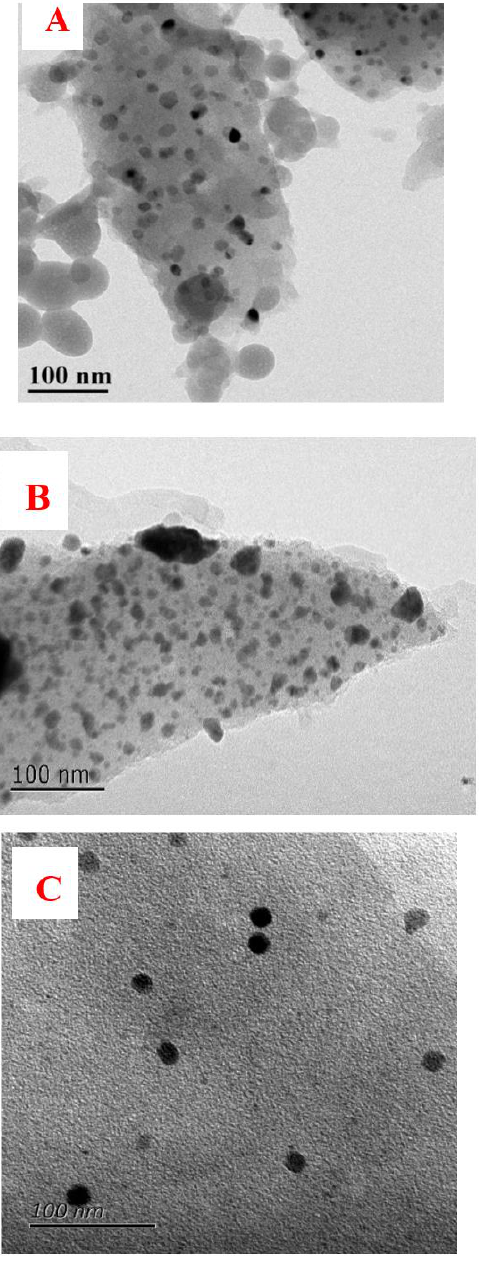
Figure 2. Three representative TEM images and their HRTEM images of Ni/AC ( A , A’ ), Ni-Re/AC (n Ni :n Re = 1:1) ( B , B’ ), and Re/AC ( C , C’ ).